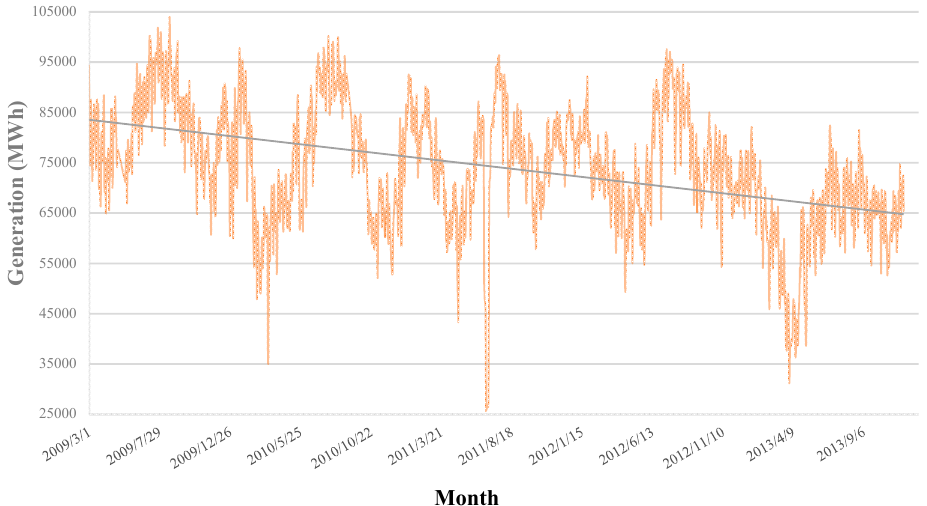
Figure 7. Daily generation from lignite-fueled plants in Greece during the period March 2009 to November 2013 (data as acquired from [48]).